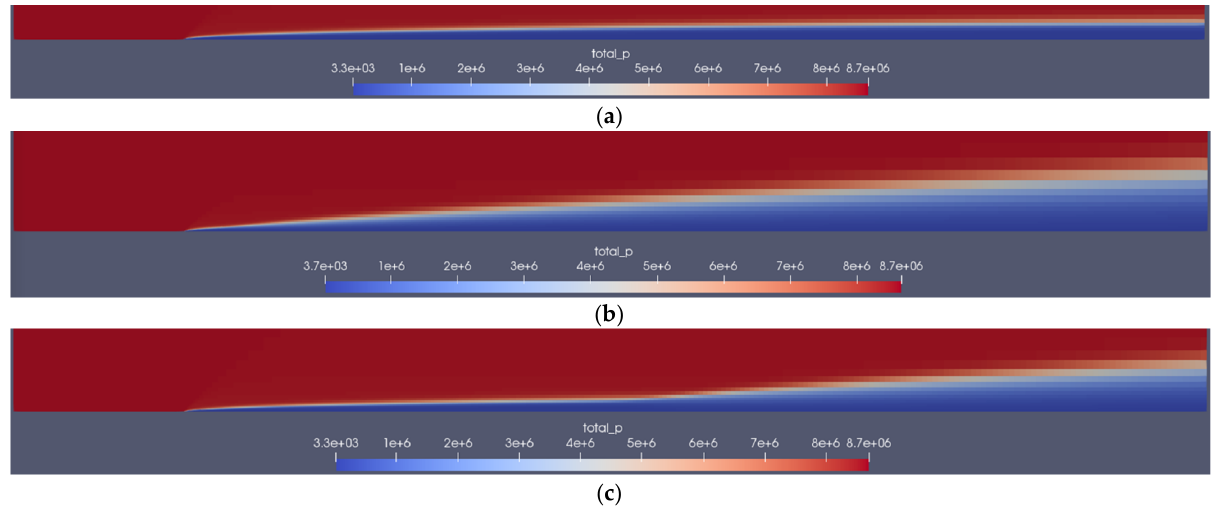
Figure A8. Total pressure profile of s00: ( a ) laminar model; ( b ) SA model; ( c ) SA-BCM model.